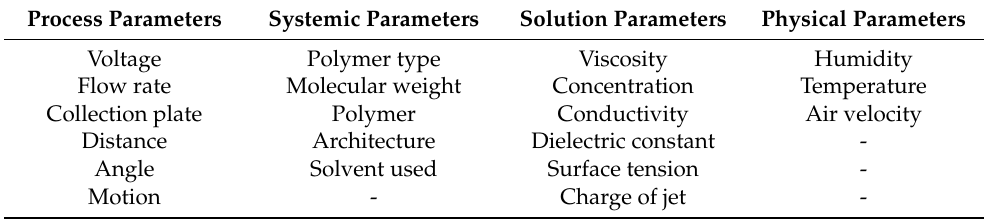
Table 2. List of variable parameter affecting the characteristics of electro-spun fibers. Process